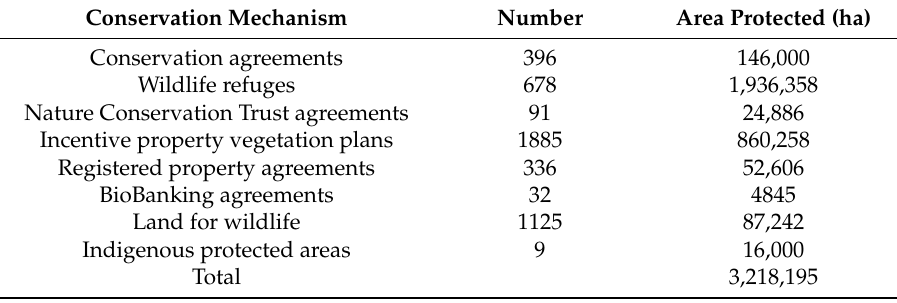
Table 2. Private land conservation mechanisms and area protected in